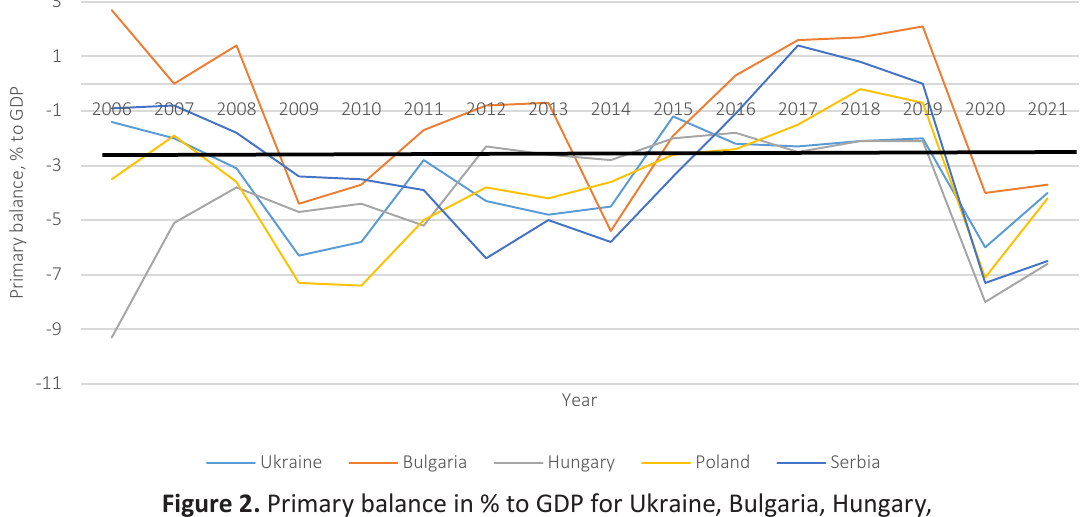
Figure 2. Primary balance in % to GDP for Ukraine, Bulgaria, Hungary, Poland, and Serbia